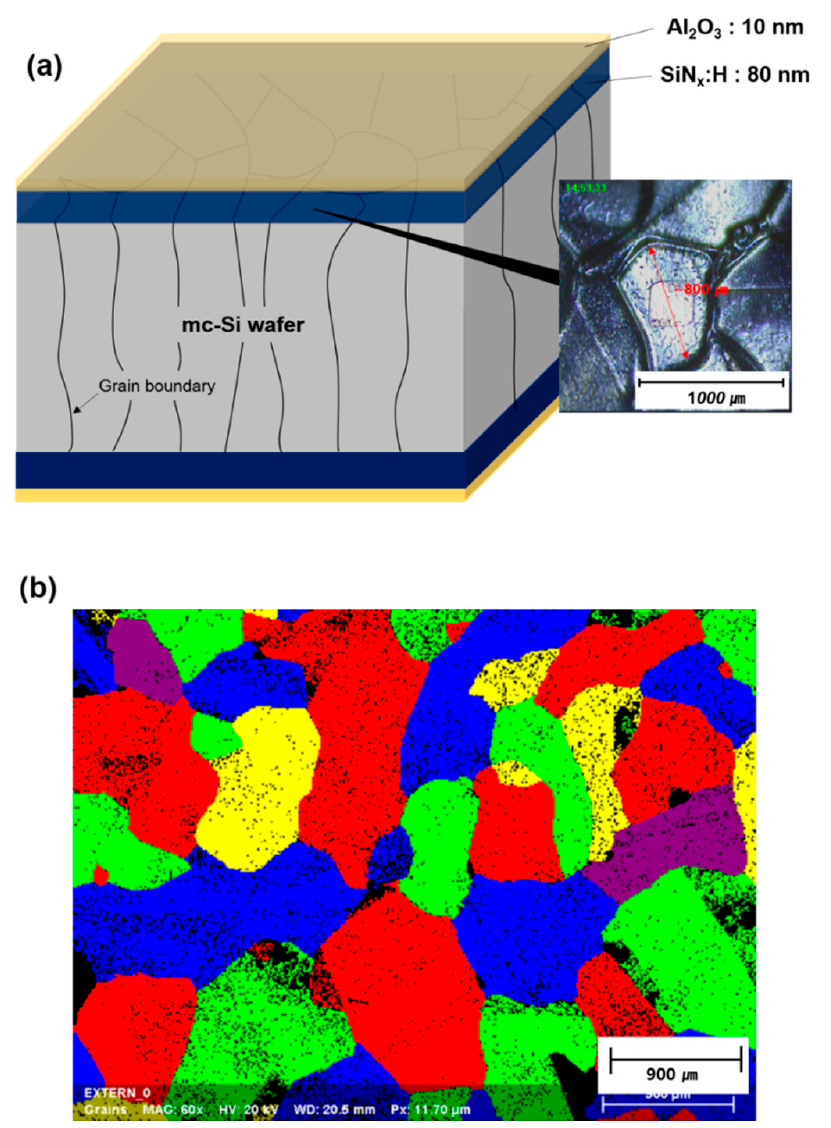
Figure 1. ( a ) Schematic diagram of the Al 2 O 3 /SiN x :H/mc–Si structure prepared for the quasi-steady-state photoconductance (QSSPC) measurement of the minority carrier lifetime. ( b ) Grain size of the mc-Si wafer obtained by electron-backscatter diffraction (EBSD).